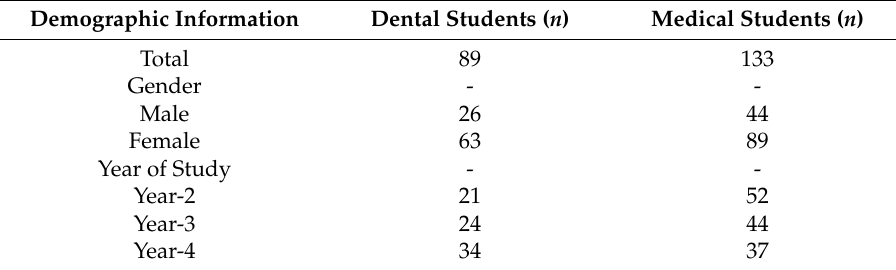
Table1. Demographics of respondents. Table 1. Demographics of respondents.